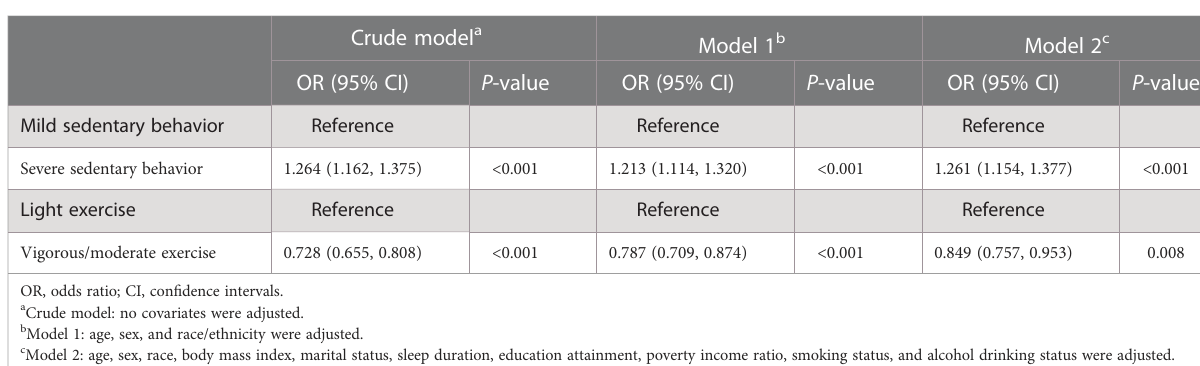
TABLE 2 The associations between sedentary behavior, exercise, and sleep